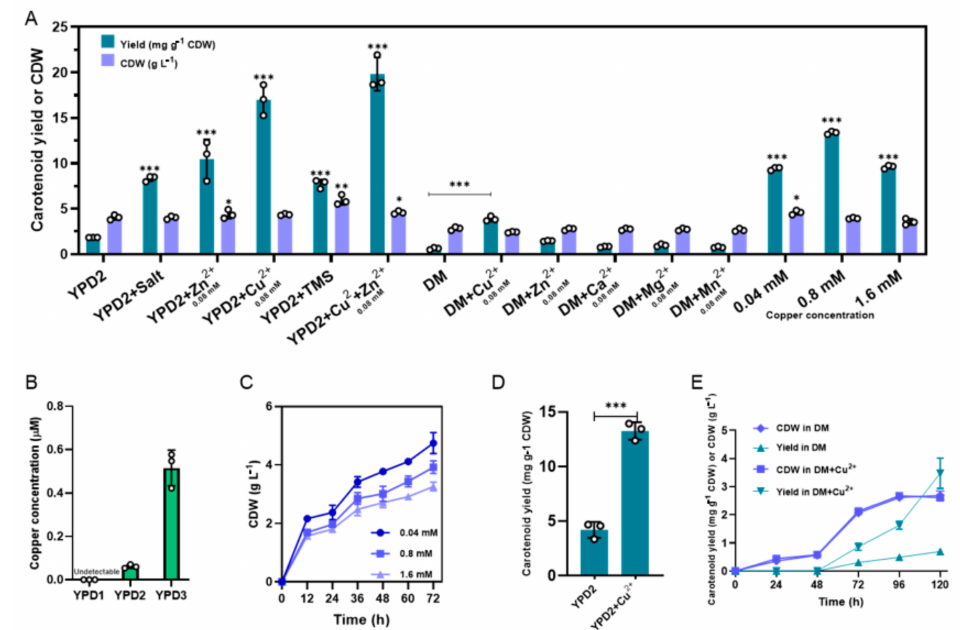
Figure 3. Carotenoid yields and cell masses in the YPD2 or defined media (DM) media supplement with different chemicals or different concentrations of copper ( A ). Copper concentrations in different yeast extractions ( B ). Growth curves of BL03-D-4 in YPD2 media supplement with different concen- trations of copper ( C ). Carotenoid yields of SC106 in YPD2 media and YPD2 supplemented with 0.08 mM copper ( D ). Time-courses of carotenoid fermentation in DM and DM supplemented with 0.08 mM copper ( E ). The values are the means and standard deviations of three biological replicates (small circles). *: significantly different based on two-tailed Student’s t -test ( p < 0.05); **: significantly different based on two-tailed Student’s t -test ( p < 0.01); ***: significantly different based on two-tailed Student’s t -test ( p <